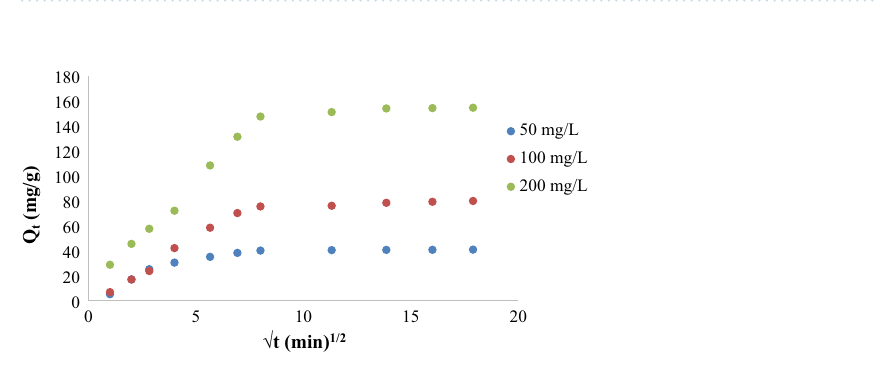
Figure 11. Model of intra-particle diffusion for KMnO 4 adsorption by